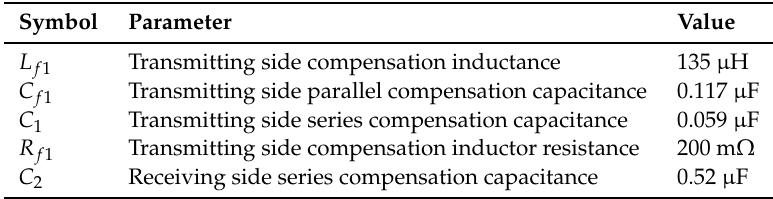
Table 2. Compensation network parameters.